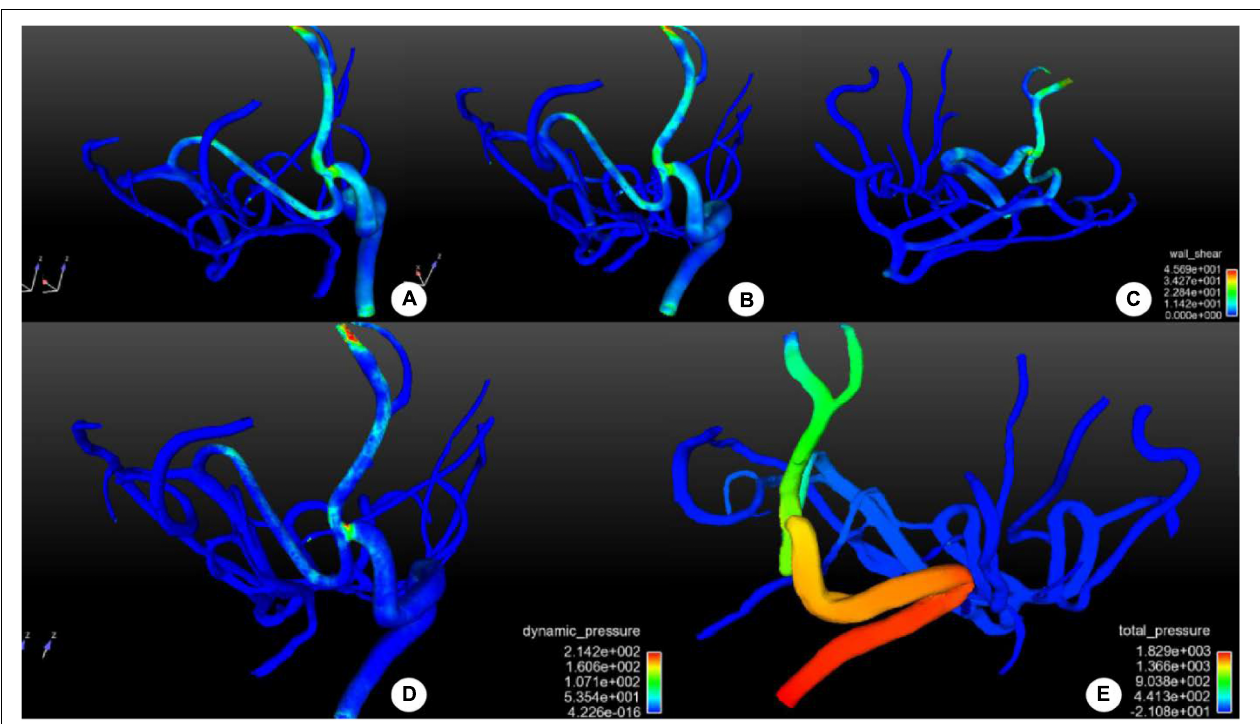
FIGURE 4 | Distribution of hemodynamic stresses in and around the surgical bypass vessel after bypass surgery. (A–C) Distribution of wall shear stress (WSS) in and around the bypass vessel was shown. No abnormal increase was demonstrated in WSS in the bypass or the anastomosis, and the middle cerebral artery supply blood reversely without producing abnormal WSS. (D) The distribution of dynamic pressure was shown, with increased dynamic pressure around the anastomosis to promote blood flow distally, but the dynamic pressure was stable in the whole vessels. (E) The distribution of total pressure was shown in and around the bypass vessel. Proximal to the anastomosis, the total pressure was high to promote blood flow distally. A low total pressure was shown in the distal branches of the middle cerebral artery, beneficial to blood entering distal branches. The color scale represents the size of the